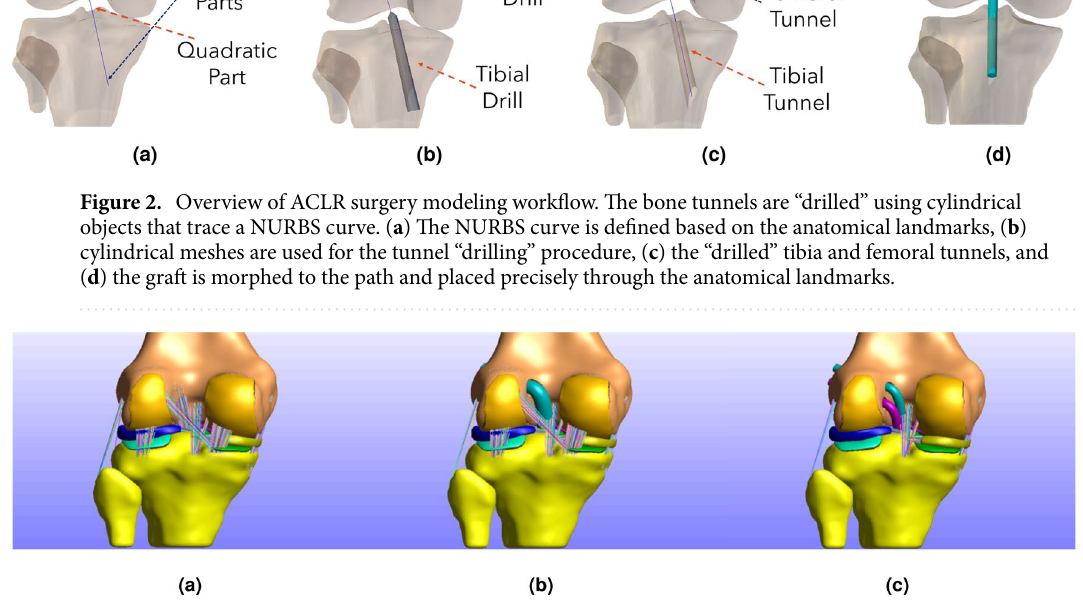
Figure 3. FE model versions. In this work, we developed three different versions of a FE knee model that correspond to ( a ) the healthy knee used for reference and comparison (RM), ( b ) the ACL reconstructed knee with the SB approach, and ( c ) the DB